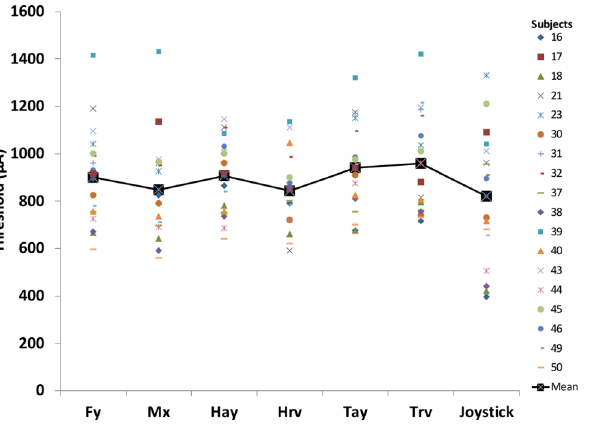
Fig 6. The threshold amplitude data estimated using the seven measures (perceptual: Joystick, and physiological body sway: Fy, Mx, Hay, Hrv, Tay, Trv) for each of the 18 subjects (see data in S5 Table).